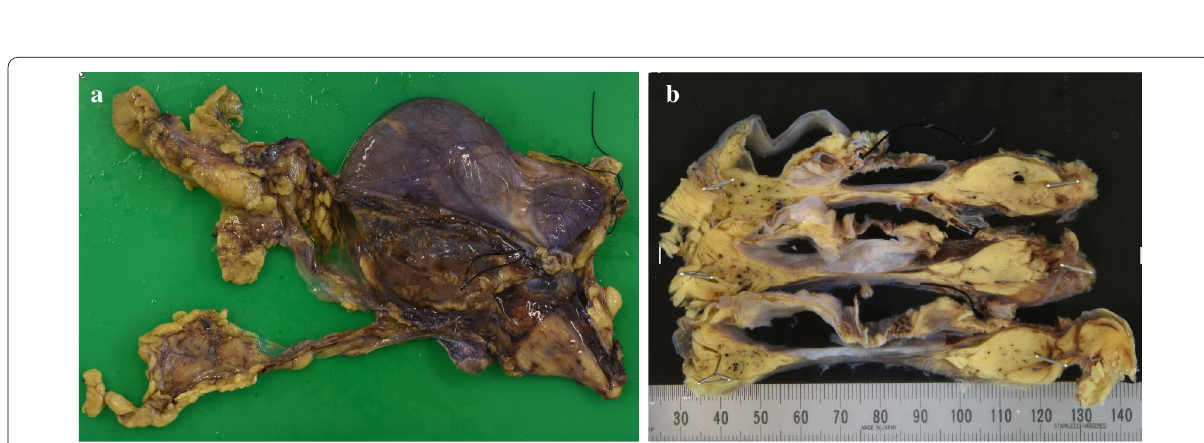
Fig. 4 a Macroscopically, the lesion was 12 a grayish-white, well-encapsulated and thin-walled